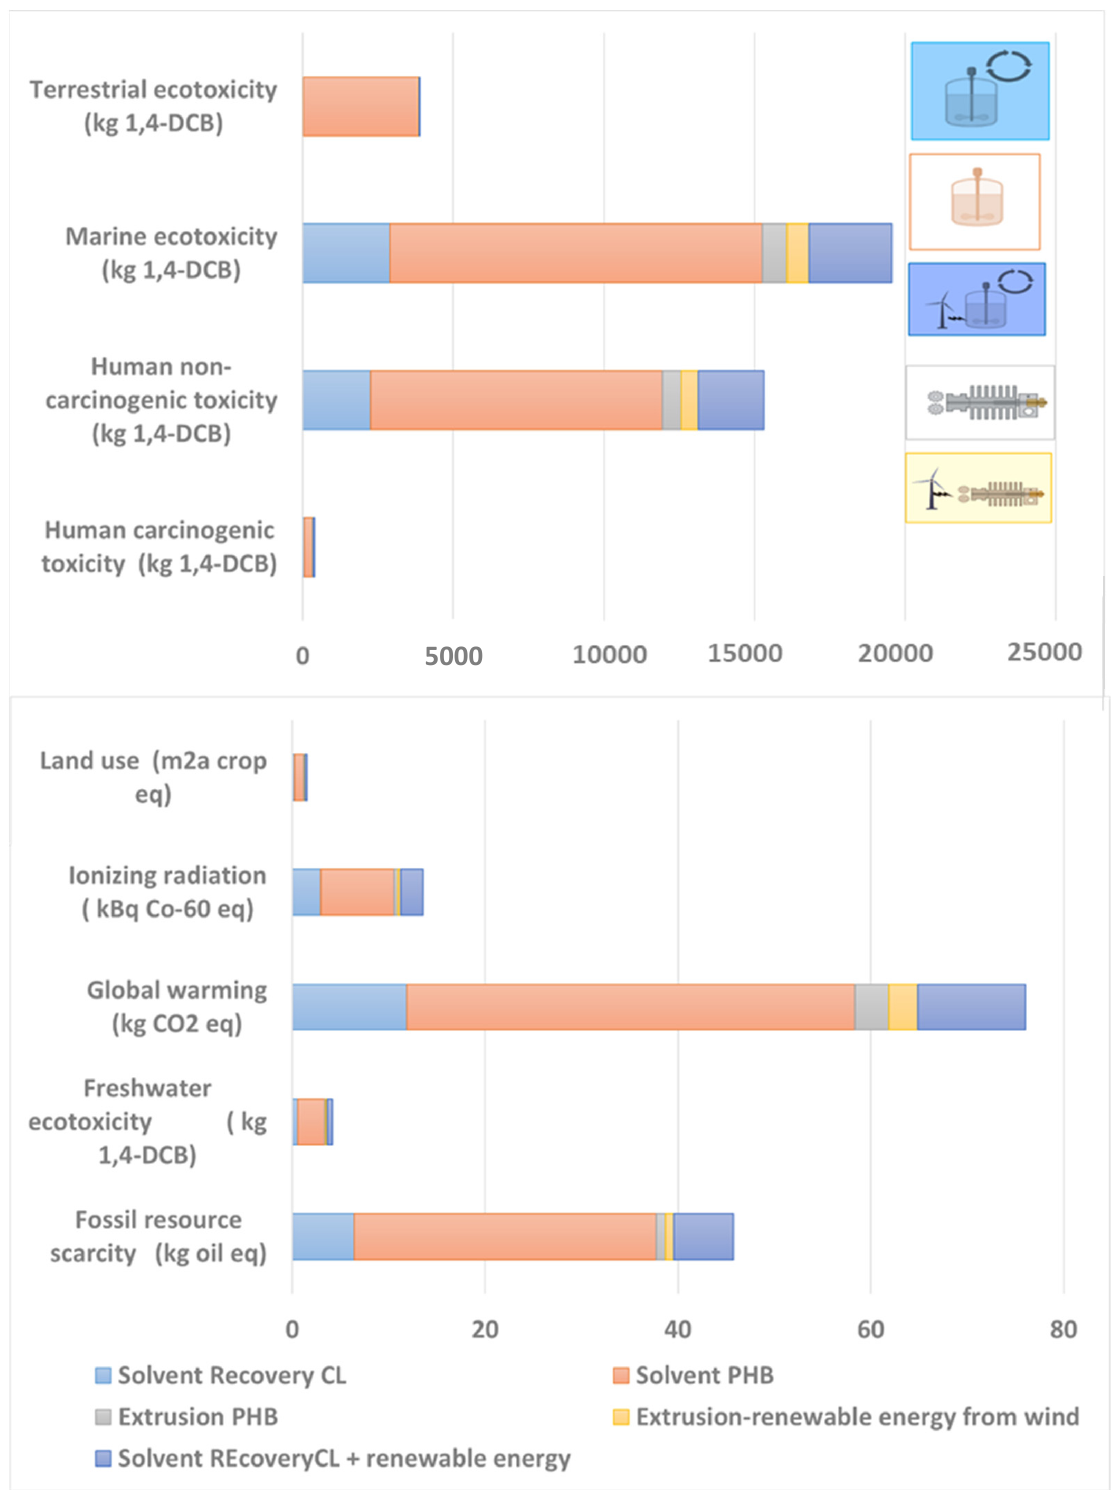
Figure 15. Contribution of each case “d” to “h” to the total of the selected environmental impact categories.